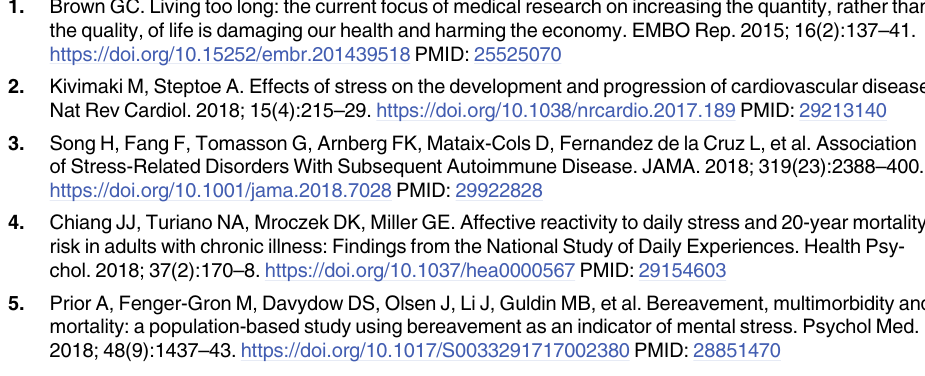
S2 Table. Bivariate correlations between measures of telomere length, age, and perceived stress. S3 Table. The change in telomere length ( Δ T/S) across perceived stress scale categories. S1 Fig. The distribution of telomere length. Left panel: ln(T/S) at baseline (visit 1) and right panel: the change in ln(T/S) over the follow-up